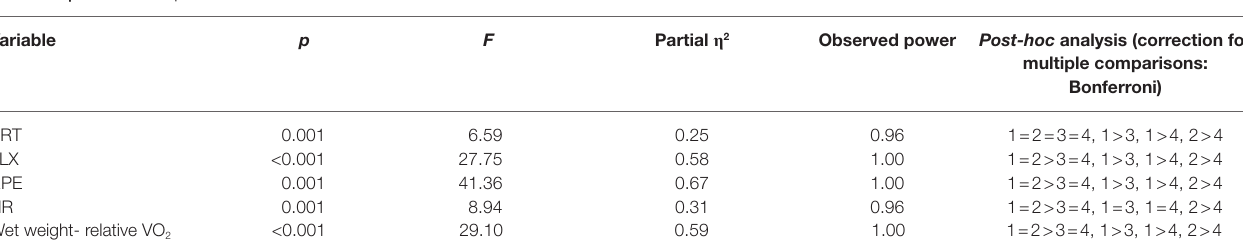
TABLE 4 | Results of repeated measures ANOVAs.